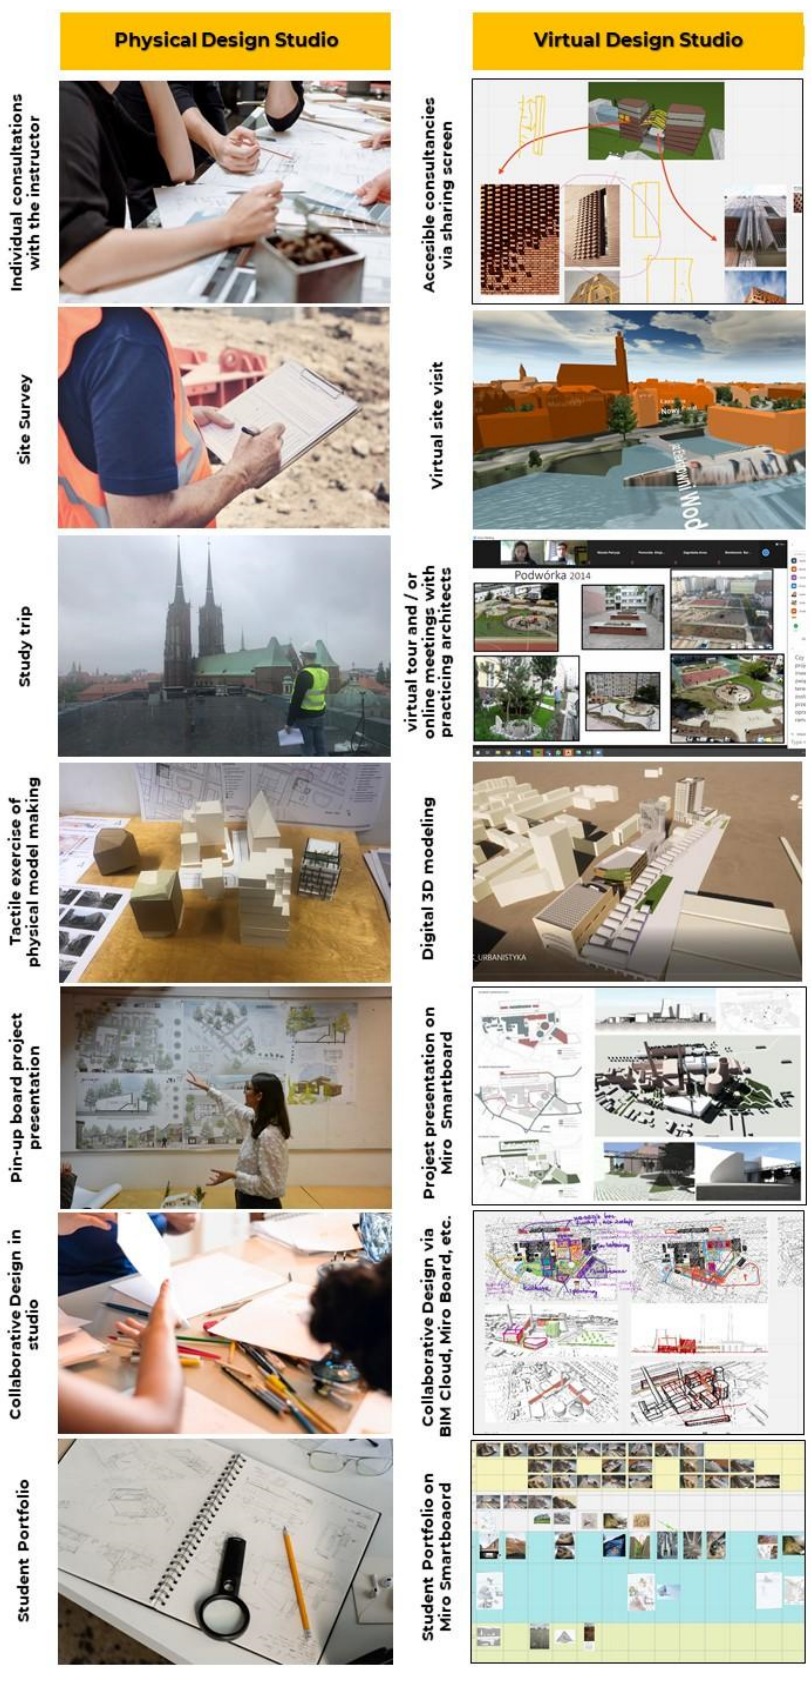
Figure 3. Common teaching and learning PDS activities and their VDS alternatives.